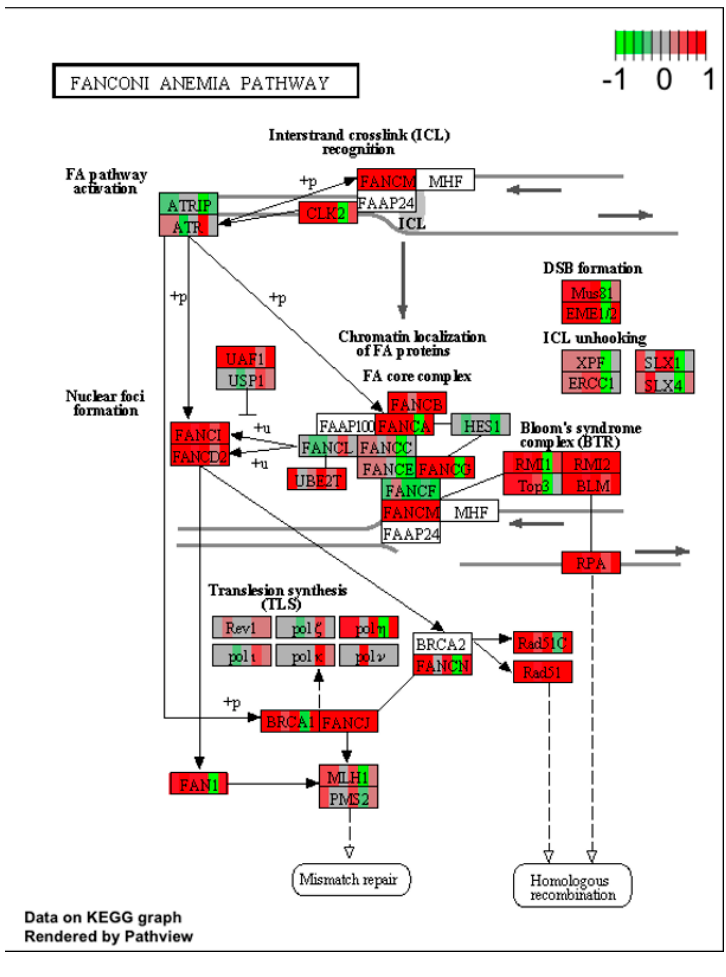
Figure 2. Example KEGG pathways upregulated by 1 / 10 SAF Corexit 9527. ( A ) p53 signaling pathway; ( B ) Mismatch repair pathway; ( C ) Homologous recombination pathway; ( D ) Fanconi anemia pathway. Red and green colors indicate up or downregulation, respectively, of gene expression for the mice in a treatment group.